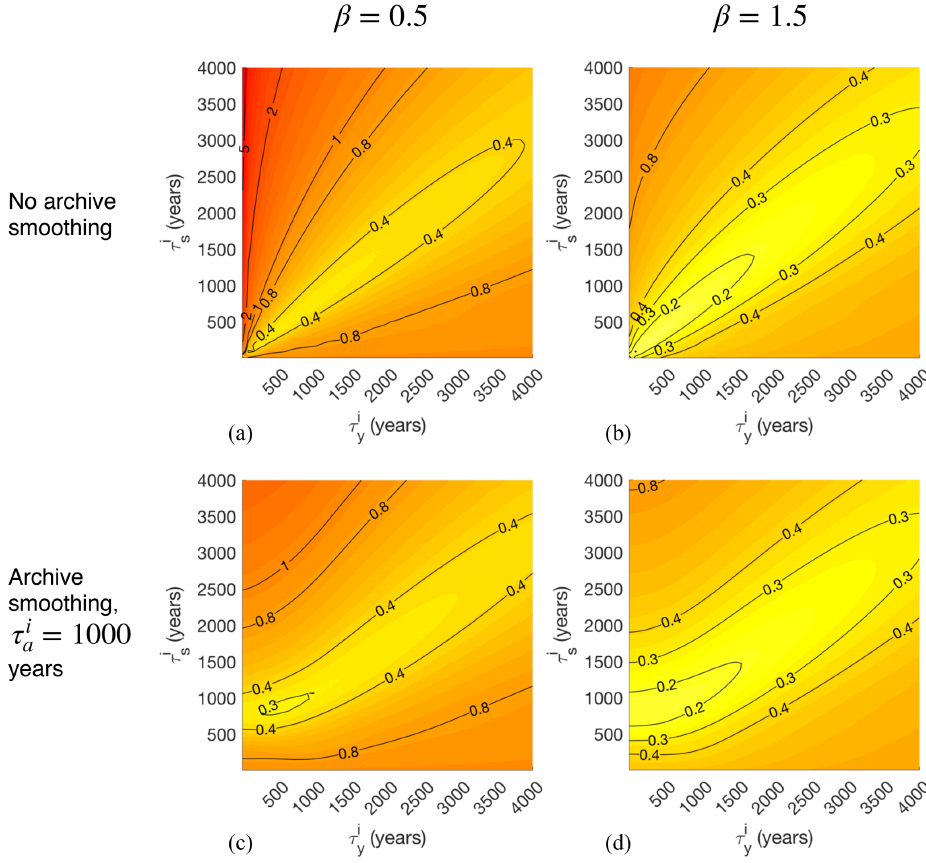
Figure 8. Same as Fig. 5, but illustrating the dependence of the error-to-signal standard deviation ratio for individual measurements in a time series as a function of local time series spacing ( τ i s ) and the observational averaging time interval τ i y .